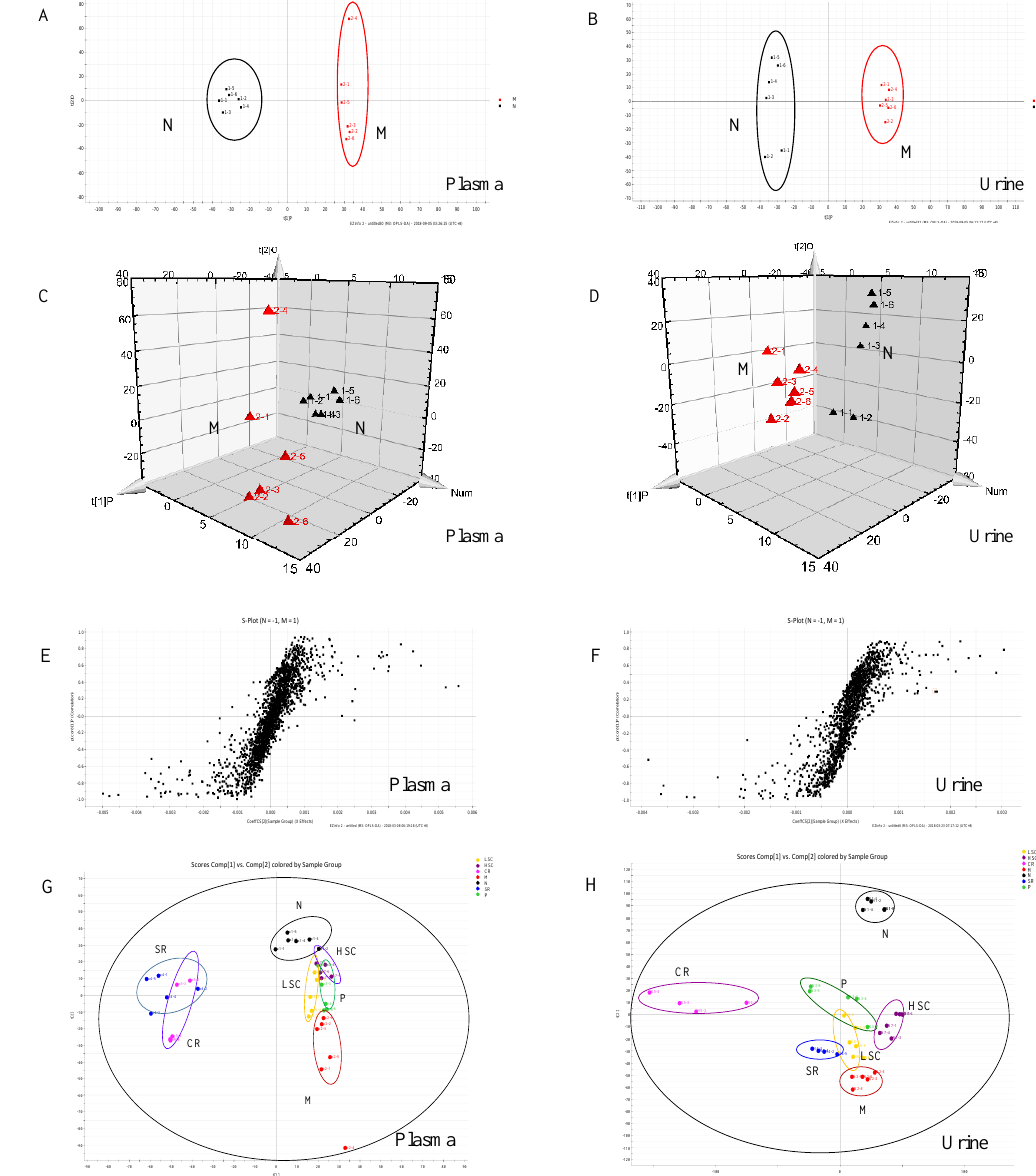
Figure 7. PCA model results between normal (N) and T2DM (M) rats in negative mode (( A ) 2-D plot of plasma; ( B ) 2-D plot of urine). 3D PLS-DA scores plot of LC–MS spectral data (( C ) plasma; ( D ) urine). S-plot of OPLS-DA model for M vs. N group (( E ) plasma; ( F ) urine). PCA analytical results from N and M rats treated with metformin (P), scutellaria Radix (SR), coptidis Rhizome (CR), low dose of combined extracts group (LSC) and high dose of combined extracts (HSC) at negative mode (( G ) plasma; ( H ) urine).